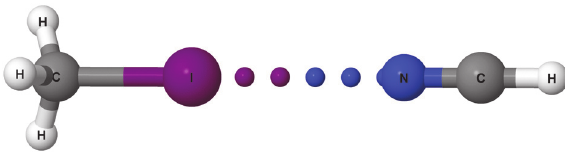
Figure 1: Structure of the investigated MH 3 X ⋅⋅⋅ NCH complexes. The optimized geometry of CH 3 I ⋅⋅⋅ NCH is shown as an example. The XB interaction is marked by a dotted